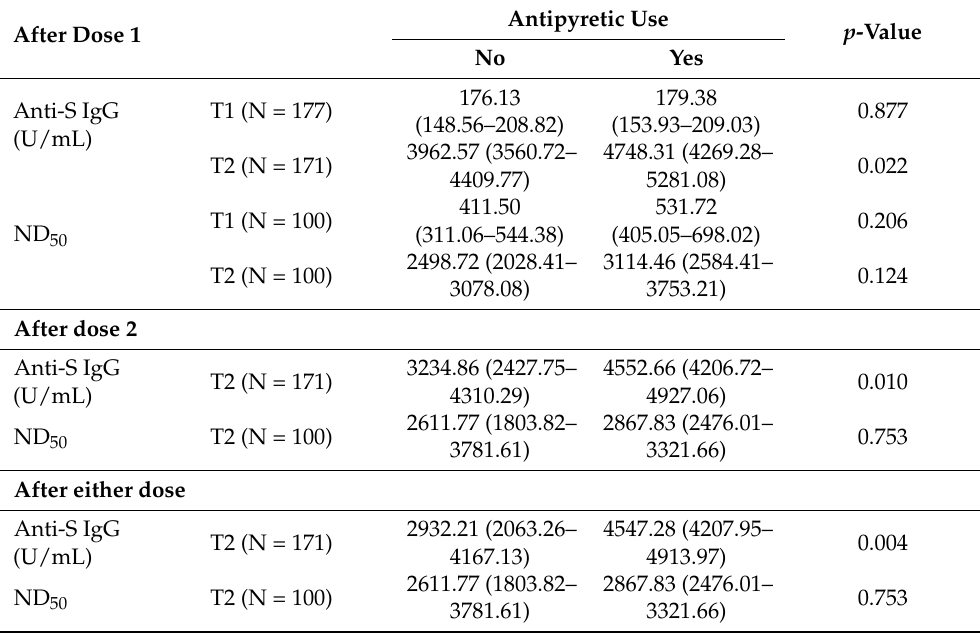
Table 3. Relationship between the use of antipyretics and antibody response.